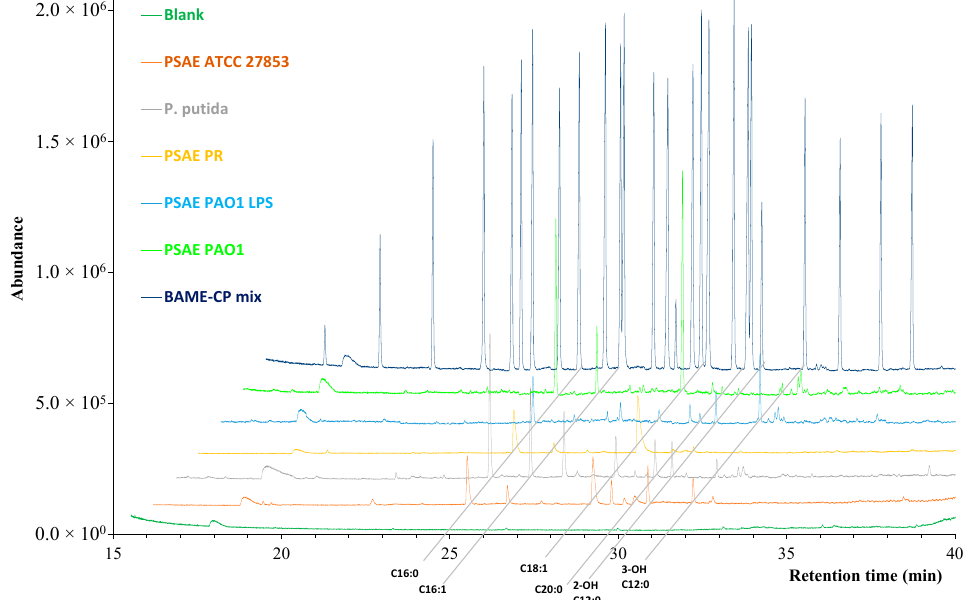
Figure 2. Total ion GC-MS chromatogram of Pseudomonas bacterial strains and PSAE PAO1 LPS, cultivated at 37 °C on agar cultivation media and on the first day of incubation, BAME CP Mixture and blank sample (the surface of the culture media without any bacteria) using the ionic liquid-based SLB-IL111 column. The main fatty acid components were indicated in the different samples. The optimized experimental conditions are given in Section